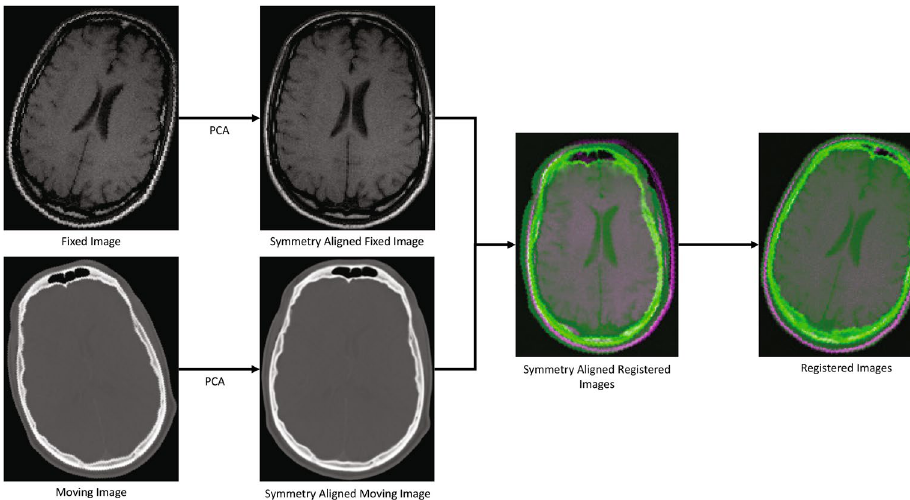
Figure 3. Ground truth generation process.